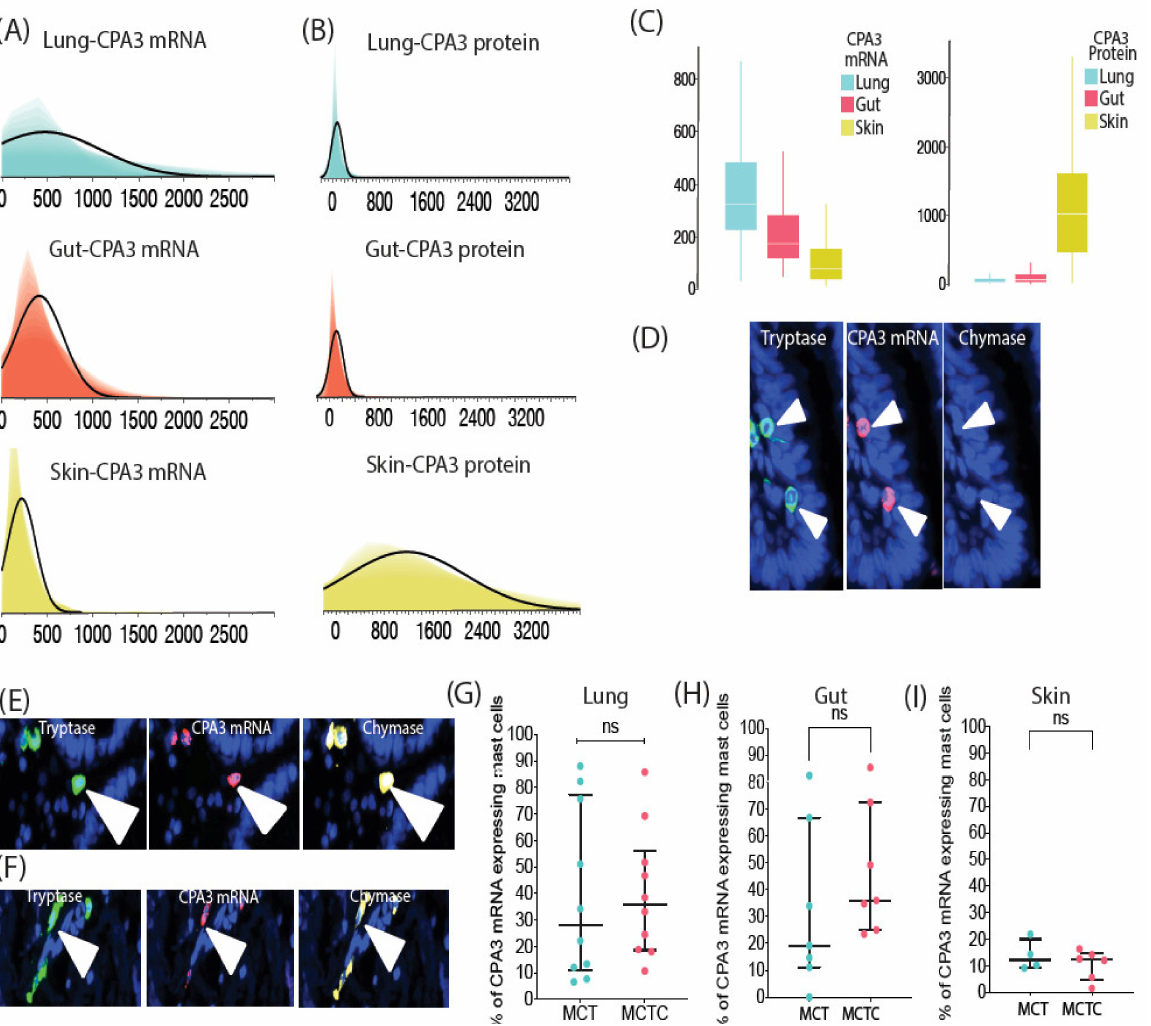
Figure 3. CPA3 mRNA expression in lung, gut and skin MCT and MCTC populations and inverse correlation of CPA3 mRNA with its protein storage in the granules. ( A , B ) Shadowgrams demonstrating the reversed expression patterns of staining intensity levels (y-axis) between CPA3 mRNA ( A ) and protein ( B ) in lung, gut and skin mast cells. Lung and gut contain significantly higher levels of CPA3 mRNA than skin ( B ). ( C ) The candlestick bar graphs illustrate further the reversed pattern of CPA3 mRNA and protein level between lung, gut and skin mast cells. ( D – F ) Immunofluorescence micrographs exemplifying CPA3 mRNA expression in lung, gut and skin mast cells, respectively. ( G – I ) Subject mean percentage of CPA3 mRNA expression by lung, gut and skin MCT and MCTC populations. Statistics : ( G – I ) Mann–Whitney test used to calculate the significance of among mast cell subpopulation in relation to CPA3 protein expression, ns = non-significant difference, i.e., p >